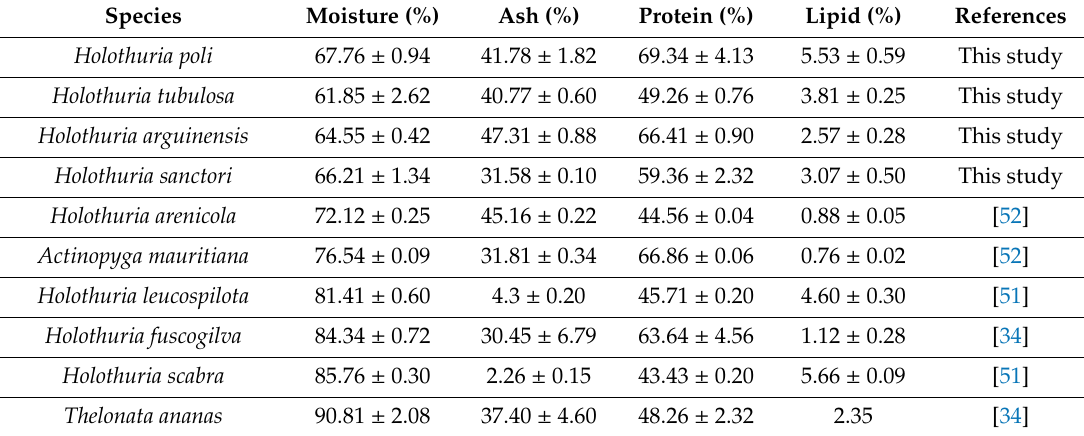
Table 1. Proximate composition (%) of the studied sea cucumbers body wall compared to other species from the Red Sea and Pacific Ocean. Mean ± SD [ n =